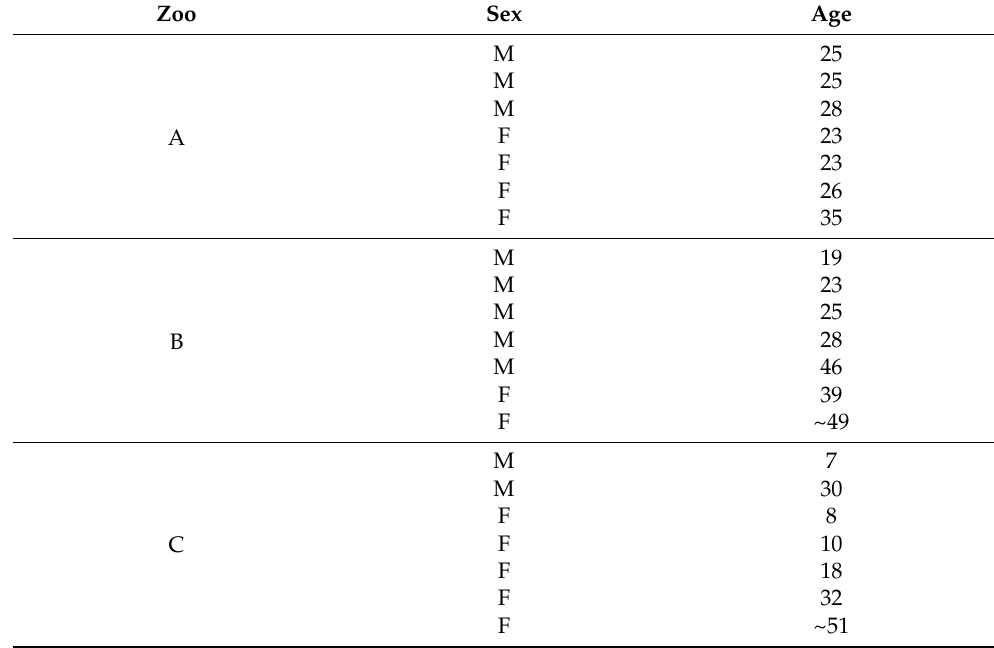
Table 1. Demographic and Group Composition Data for Each Enrolled Chimpanzee.